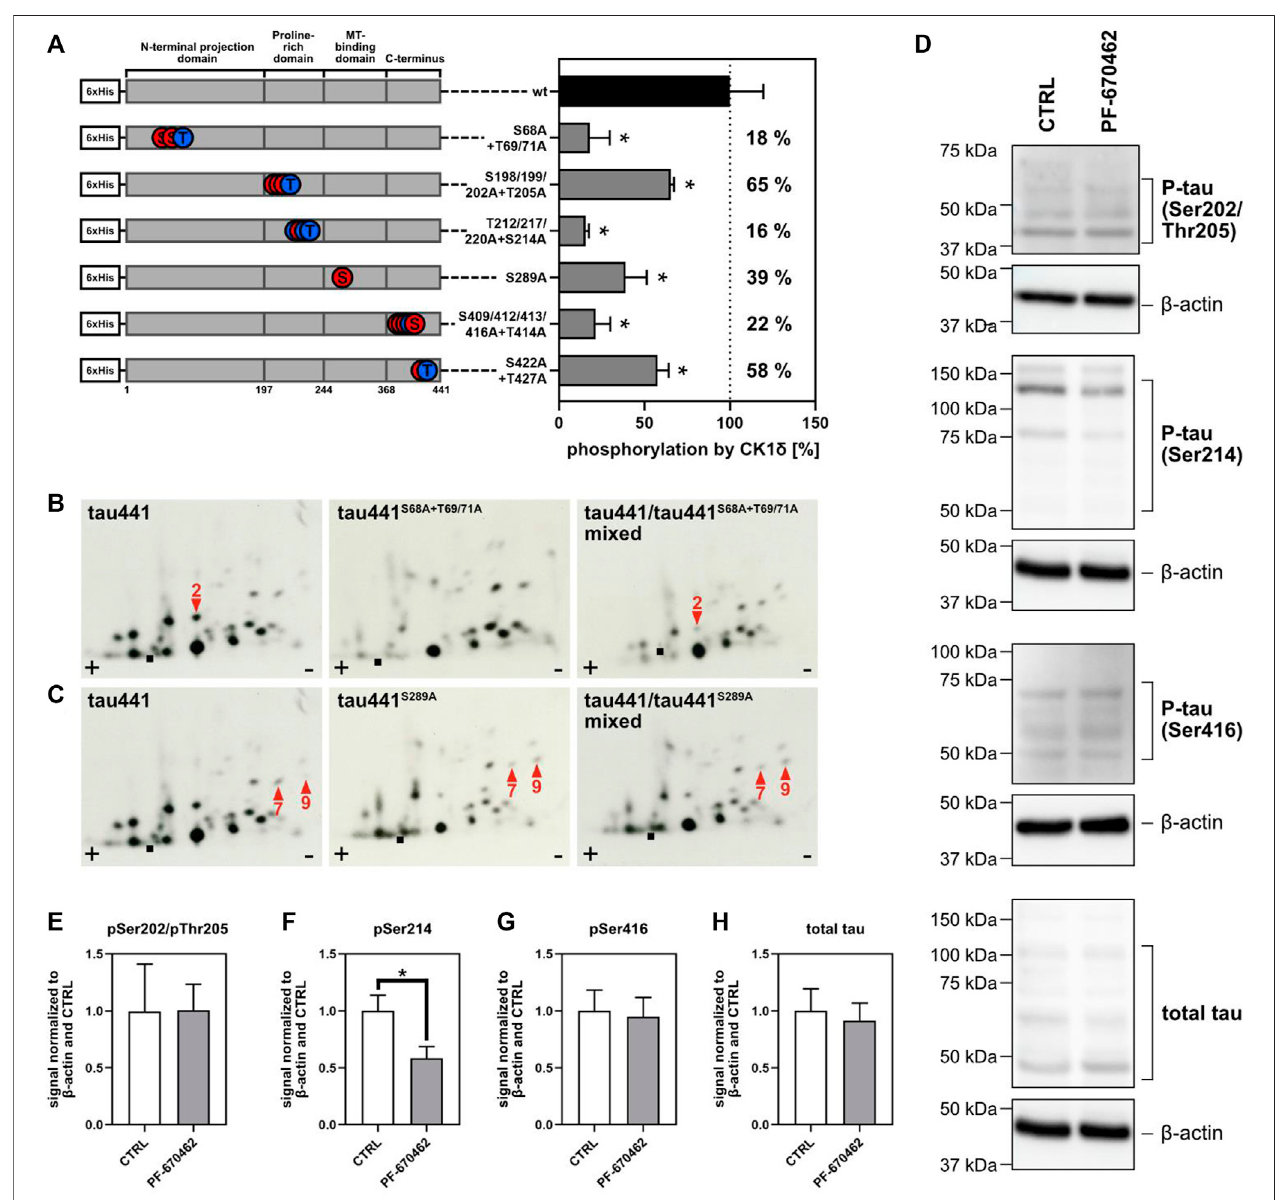
FIGURE 5 | CK1 δ targets AD-associated phosphorylation sites on tau441. (A) Tau441 and tau441 phosphomutants were phosphorylated by CK1 δ in vitro using radioactively labeled 32 P phosphate. Phosphate incorporation was quanti fi ed and normalized to wild type (wt) tau441. Information about the localization of the mutated phosphorylation sites on tau441 are shown on the left side of the fi gure. A: alanine, S: serine, T: threonine, wt: wild type. Phosphopeptide analysis of CK1 δ - phosphorylatedtau441phosphomutants (B) tau441 S68A+T69A+T71A and (C) tau441 S289A .Arrowpositionindicatethelossofamajorphosphopeptideorchangesin the phosphorylation pattern. Phosphopeptide analysis of mixed samples con fi rm the identity of the marked phosphopeptides. ■ : loading point of samples, +: anode, − : cathode. (D) Transduced and differentiated hNPCs were treated with 1 µM PF-670462 or DMSO as vehicle control (CTRL). Tau phosphorylation was determined by Western blots and antibodies targeting pSer202/pThr205-tau, pSer214-tau, pSer416-tau and total tau. β -actin was used as loading control. (E – H) Western blot signal intensities were quanti fi ed and normalized to β -actin and CTRL (vehicle control). Experiments were performed in triplicates and are shown as mean values. Error bars represent the standard deviation. Statistical signi fi cance was tested using the nonparametric Mann-Whitney U test with * p ≤ 0.05.